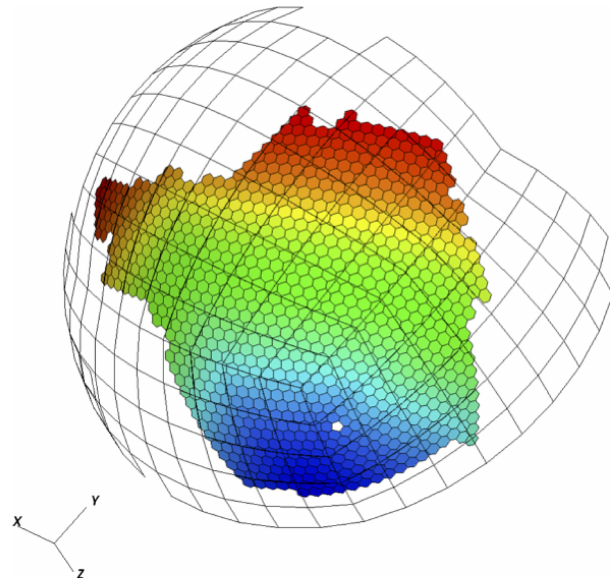
Figure 7. Source coverage mesh fully covers local target mesh; lo- cal intersection proceeds between the source atmosphere (quadran- gle) and the target ocean (polygonal)